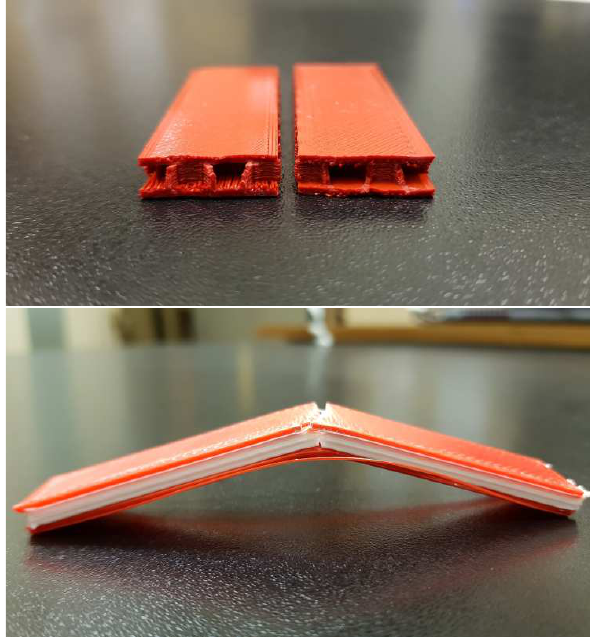
Figure 3: Specimen 1 (on the top) and specimen 6 (on the bottom) after the three-point bending